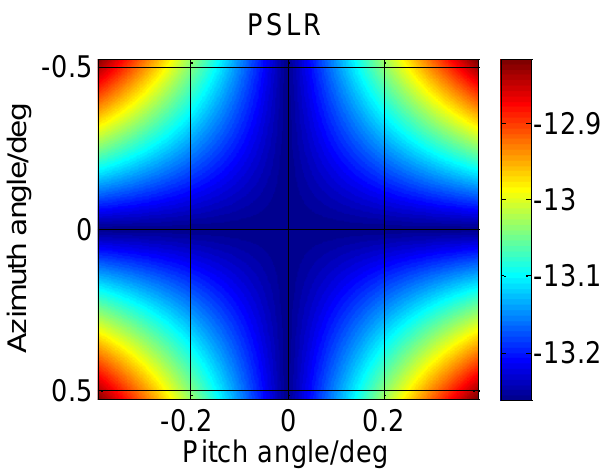
Figure 24. PSLR at shortest distance.